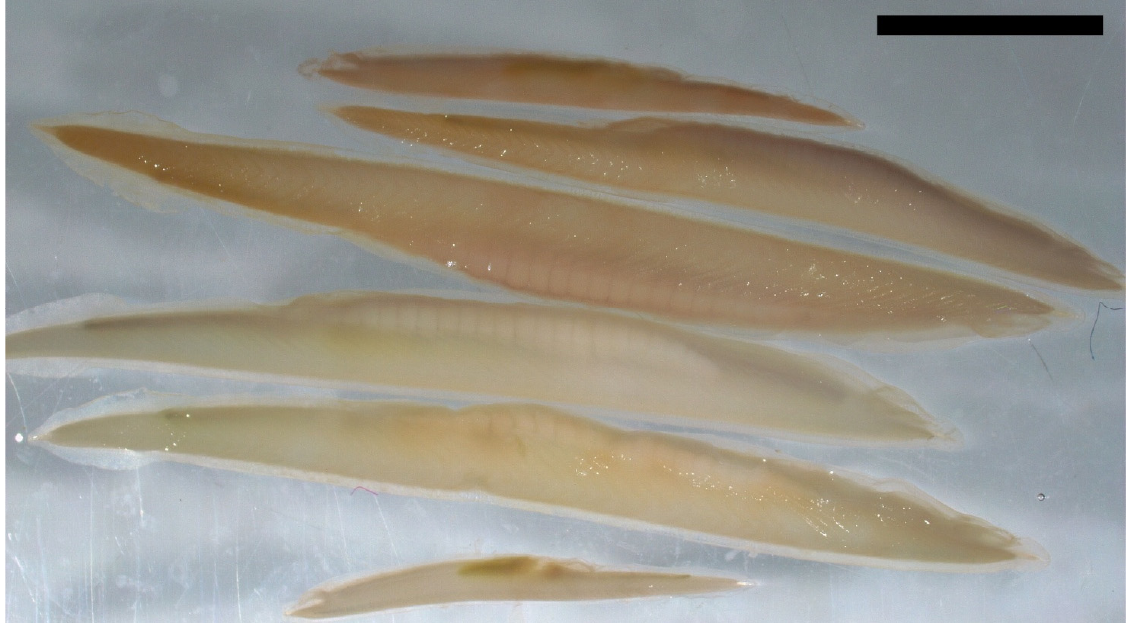
Figure 1. Some specimens of Branchiostoma lanceolatum sampled at Capo Mulini. Scale bar: 0.5 cm. Photo credit: Giuseppe Catalano.